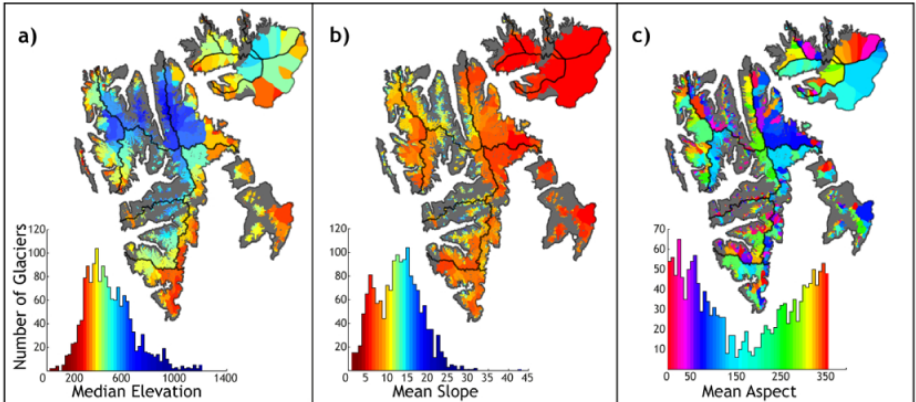
Fig. 5. Spatial distribution of (a) median elevation, (b) mean slope in degrees and (c) mean aspect in degrees from north. The color scale is shown as a histogram with the number of glaciers. The distribution of mean slope is slightly bimodal, reflecting two styles of glaciation: the flatter glaciers and icecaps that fill valley floors, and the steeper cirque-style glaciers that sit higher up along the valley walls. The distribution of mean aspect per glacier suggests a dominance of north-facing glaciers; however, histograms of all glacier DEM pixel aspects show a uniform distribution with aspect. The histogram thus reflects the dominance of small glaciers facing northward.